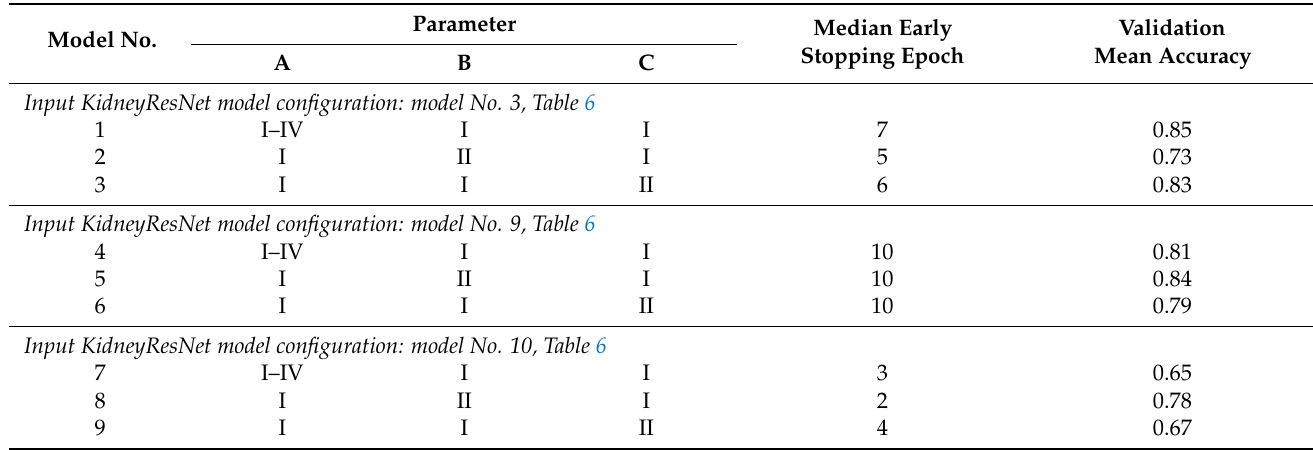
Table 7. Classification results on the validation data set for the assignment of kidneys into three functional classes depending on the data augmentation methods. The explanations for parameters A − C and I − IV are given Section 2.8.